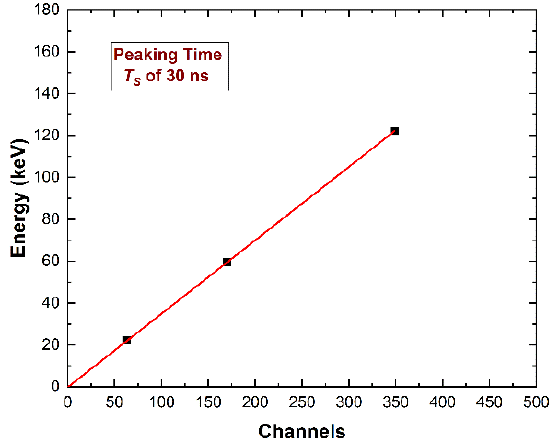
Figure 8. The photon energy vs. the pulse height (channels) obtained using the ballistic deficit pulse processing approach. The linearity with energy was well verified.